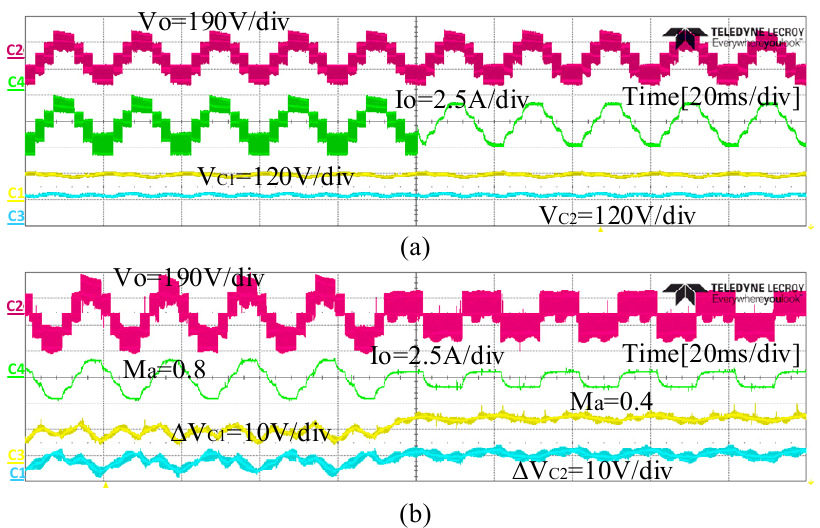
Figure 5. Step response with variation of ( a ) load from RL-load ( R = 100 Ω , L = 200 mH) to R-load Figure 5 . Step response with variation of ( a ) load from RL-load ( R = 100 Ω , L = 200 mH) to R-load ( R = 100 Ω ), and of ( b ) modulation index from M = 0.8 to M = 0.4. ( R = 100 Ω ), and of ( b ) modulation index from M = 0.8 to M = 0.4.